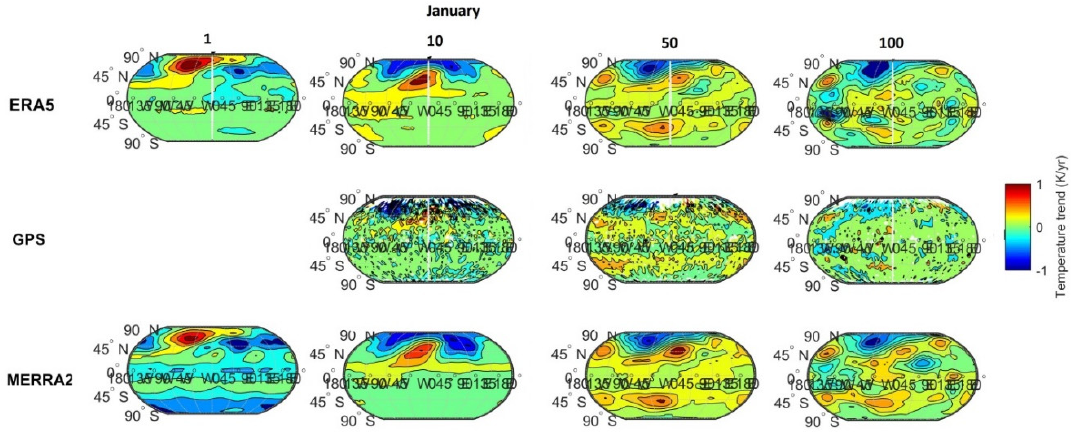
Figure 9. Temperature trends for January, period 2004–2018. ERA5 reanalysis on the top panels, GPS RO on middle panels, and MERRA2 on the bottom panels for pressure levels 1, 10, 50, and 100 hPa.